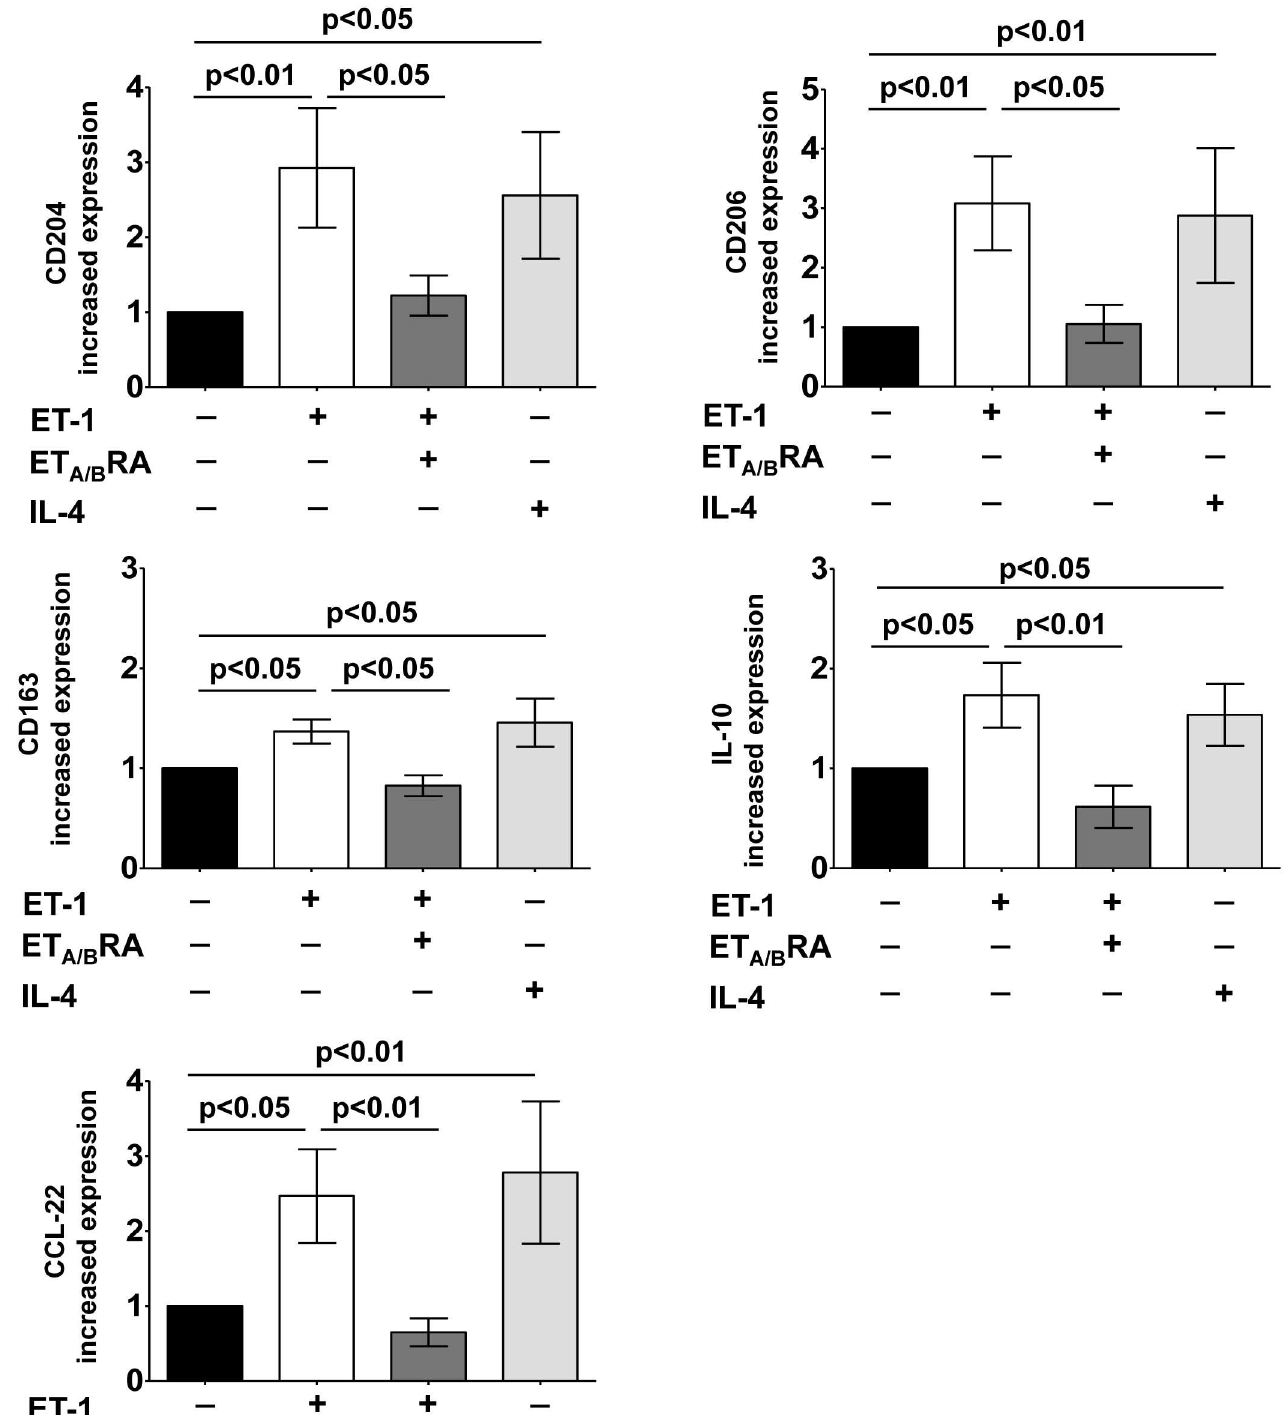
Fig 5. Evaluation of gene expression of M2 macrophage phenotype markersin cultured THP-1-derived macrophages. Quantitative real time polymerase chain reaction(qRT-PCR) of CD204, CD206, CD163, IL-10 and CCL-22gene expressionin cultured THP-1-derived macrophages (M0 macrophages) treated for 72 hours with ET-1 (100nM) and IL-4 (10ng/mL) alone, or pre-treatedwith ET A/B RA (bosentan, 10 -5 M) for 1 hour before being stimulated with ET-1. CulturedM0 macrophages maintained for 72 hours in RPMI at 5% of FBS were used as controls (M0-controls). The qRT-PCR was performed on six independent in vitro experiments and the data of CD204,CD206, CD163, IL-10 and CCL-22gene expression are shown as mean ± SDand indicatedas increasein gene expression.